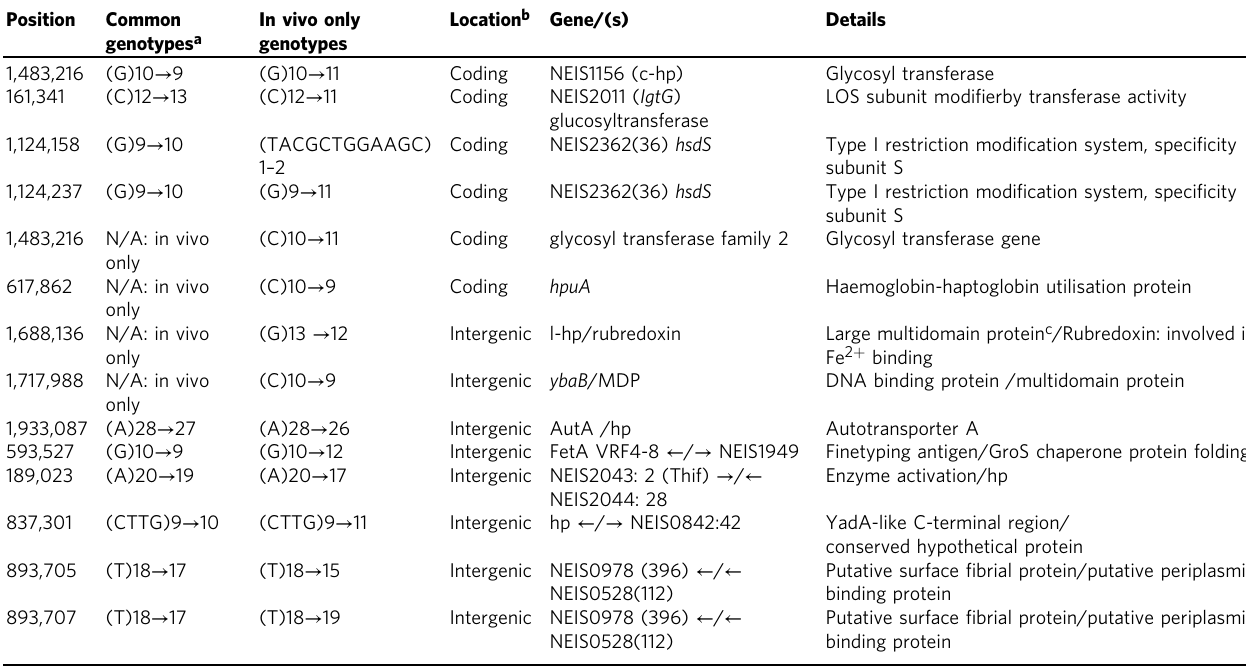
a Common genotypes are those that were found in both in vivo and in vitro datasets b Locations are wither within coding sequences or intergenic. For the latter this simply refers to a location outside a known CDS, no inference to upstream promoters has been made c Multi Domain Protein contained the following domains (yadA Hia auto transporter, chromosome segregation ATPase, fl agellin)